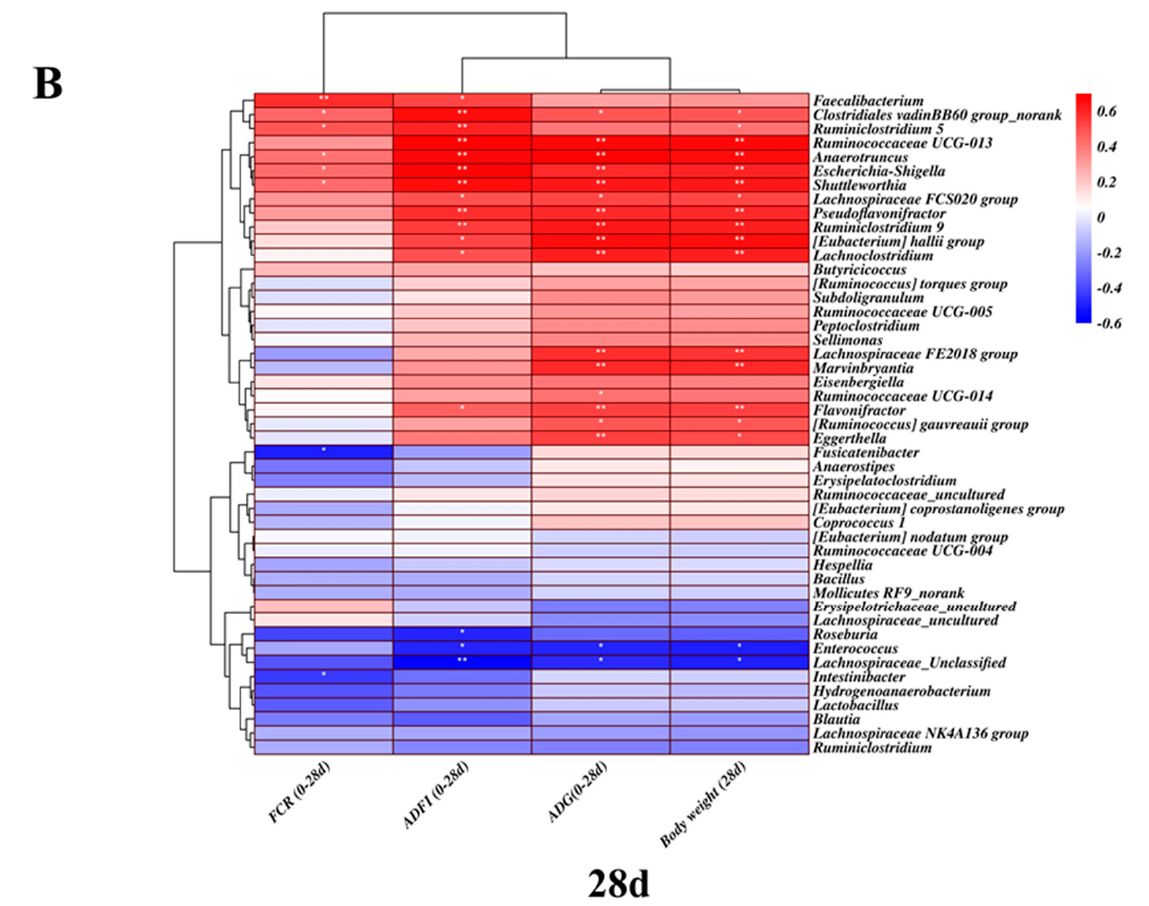
Figure 7. Correlation analysis between the relative abundance of different bacterial genera and the growth performance of chickens at different growth stages: ( A ) Day 14 and ( B ) Day 28. The asterisk represents its significance. * p < 0.05, ** p < 0.01.